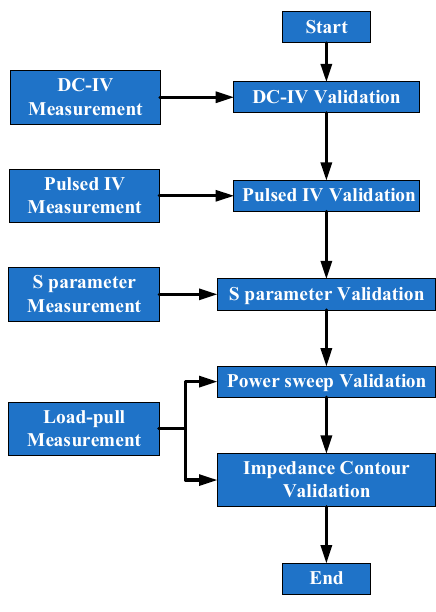
Figure 3. Flow chart of the validation procedure of the proposed model.